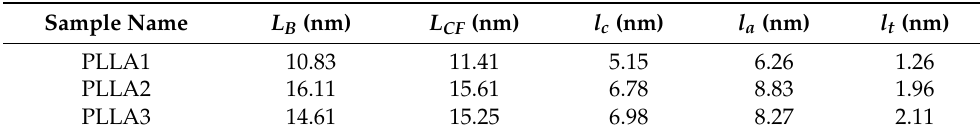
Figure 6b. According to the above calculation methods, Table 2 lists the SAXS data analysis results of the PLLA1, PLLA2, and PLLA3 samples. Table 2. The Bragg long periods ( L B ), correlation function long periods ( L CF ), crystal thicknesses ( l c ), amorphous layer thicknesses ( l a ) and transition region thicknesses ( l t ) of the PLLA1, PLLA2 and PLLA3